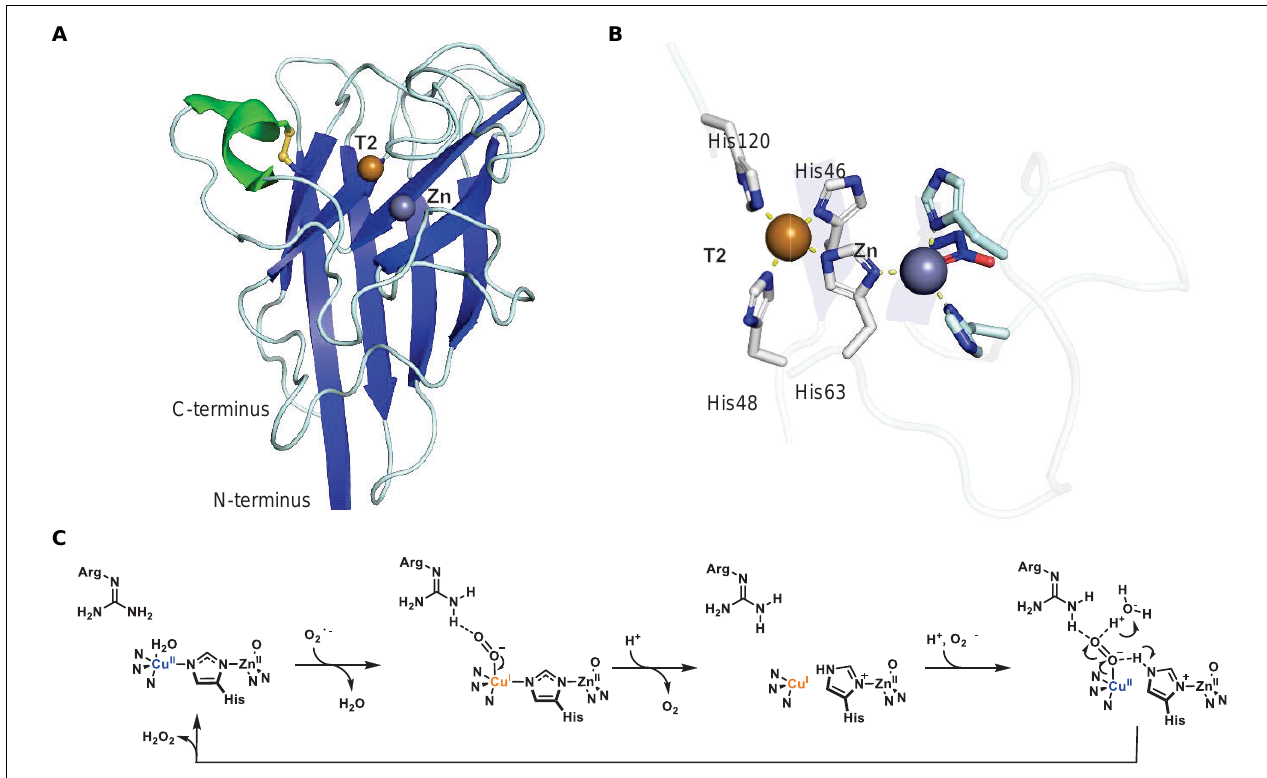
FIGURE 6 | Structure of a plant Cu,Zn-superoxide dismutase. (A) Protein structure of spinach Cu,Zn-superoxide dismutase (PDB ID: 1SRD) (Kitagawa and Katsube, 1994). (B) T2 copper center of spinach Cu,Zn-SOD. Copper coordination is highlighted by yellow dashed lines. In panels (A,B) , α -helices are highlighted in green, β -sheets are highlighted in blue. Copper atoms are shown as brown spheres, zinc atoms as purple spheres. (C) Proposed catalytic mechanism of Cu,Zn-SOD. Adapted with permission from Tainer et al. (1983; Copyright 1983 Springer Nature).